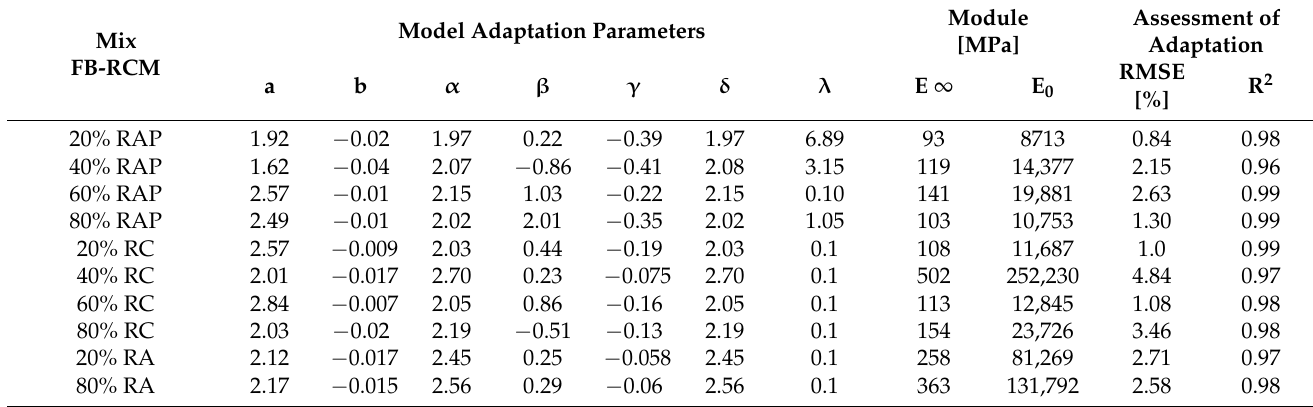
Table 12. Parameters of adaptation of module E * master